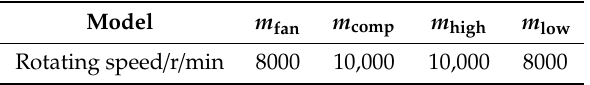
Table 2. Motion parameters of the rotors of the turbofan engine.